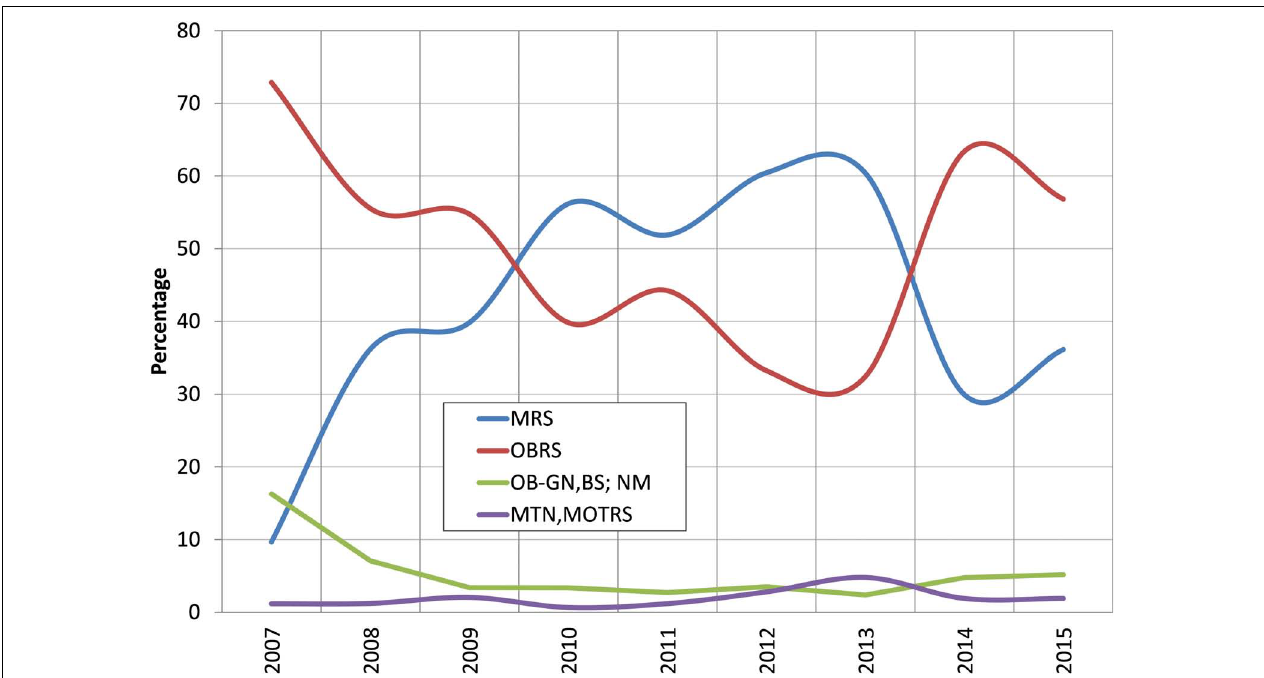
FIGURE 3 | Percent contribution of different gears to oil sardine catches during 2007–2015. MRS, mechanized ring seines; OBRS, outboard ring seines; OB-GN, outboard gillnetters; BS, beach seines; NM, non-mechanized; MTN, mechanized trawl nets; MOTRS, mechanized other gears.